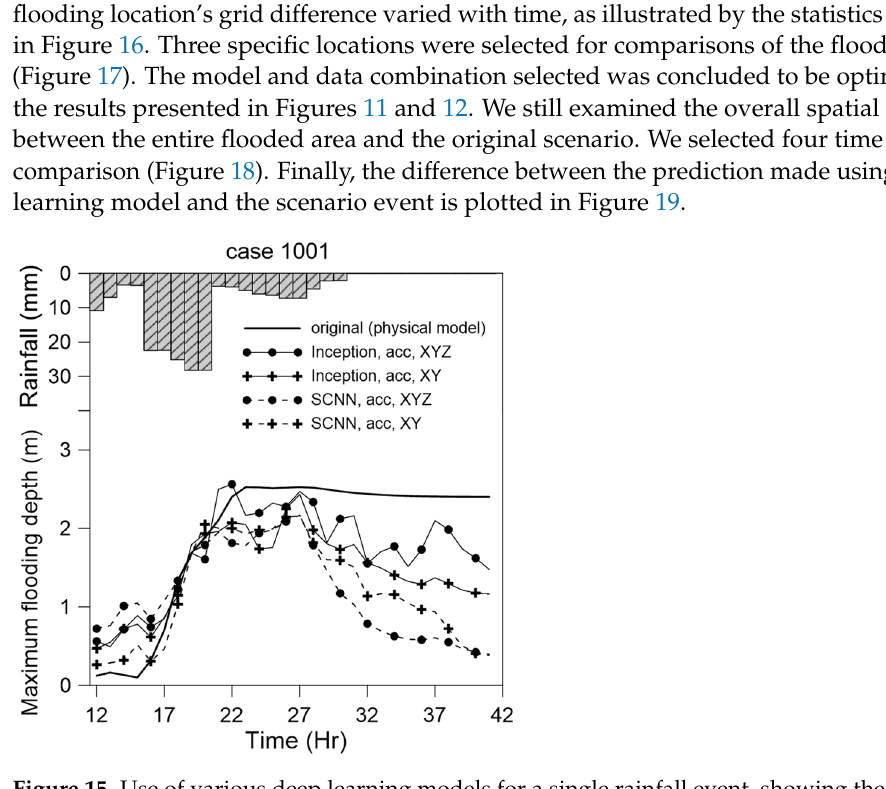
Figure 15. Use of various deep learning models for a single rainfall event, showing the maximum flooding depth versus time. flooding depth versus